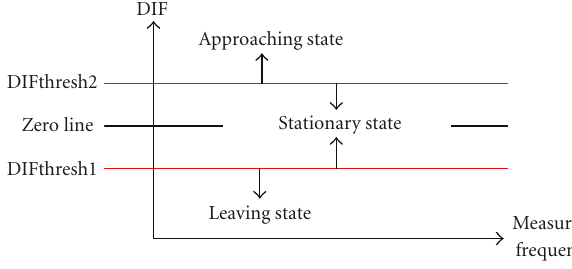
Figure 1: Determining user’s